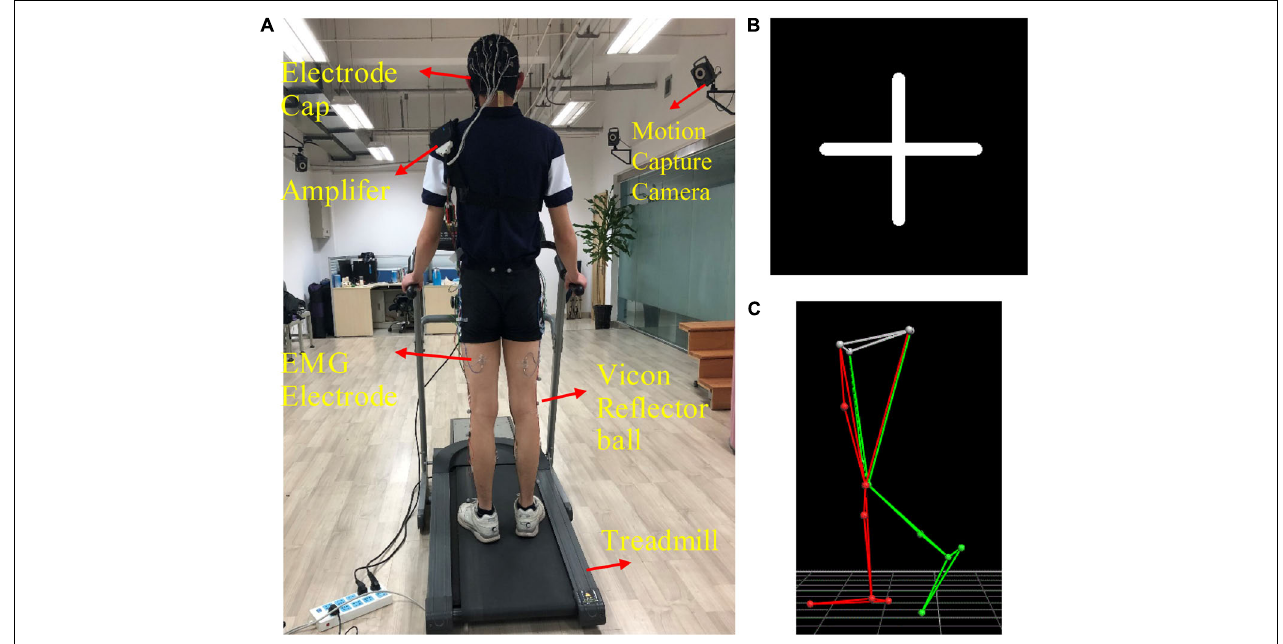
FIGURE 1 | (A) The experimental device, (B) the cross symbol, and (C) the lower limb model in the motion capture system. The 16 positions of the Vicon reflector balls are the anterior superior iliac, posterior superior iliac, thigh, knee, tibia, ankle, heel, and toe,